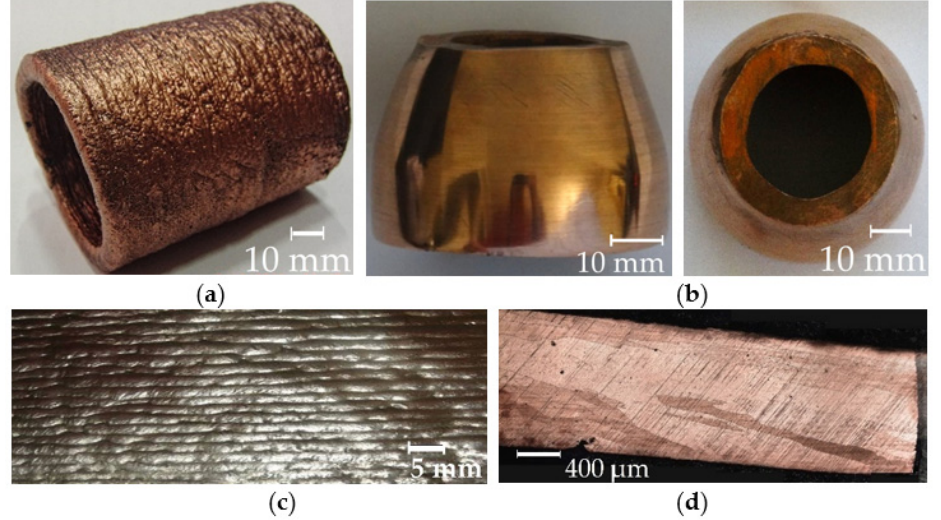
Figure 21. Bronze nozzle with CuCr0.7 wire in WAAM: before ( a ) and after ( b ) machining; the macrostructure of the surface ( c ) and the microstructure of the cross-section of the wall specimen ( d ). The diameter of the nozzle is 60 mm, the thickness of the specimen before machining is 5 mm. WAAM with the addition of 1.6 wt.% SF 6 into argon.